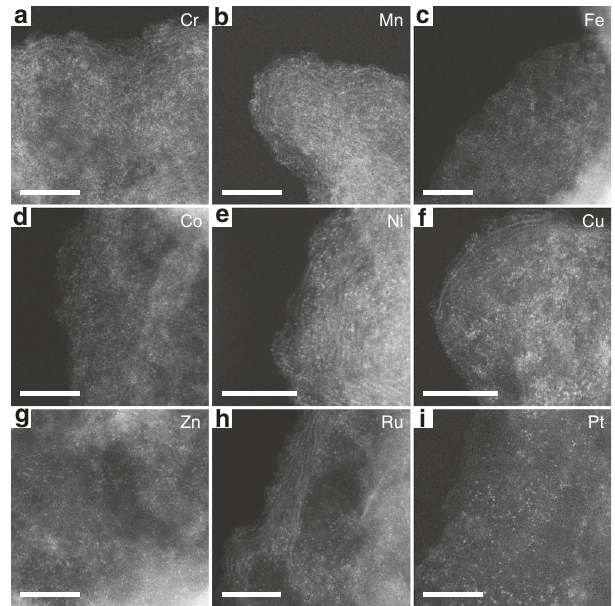
Fig. 3 Images for various metal single-atom catalysts. Aberration-corrected high-angle annular dark- fi eld scanning transmission electron microscopy for a Cr-SAC, b Mn-SAC, c Fe-SAC, d Co-SAC, e Ni-SAC, f Cu-SAC, g Zn- SAC, h Ru-SAC, and i Pt-SAC. Scale bar: 5